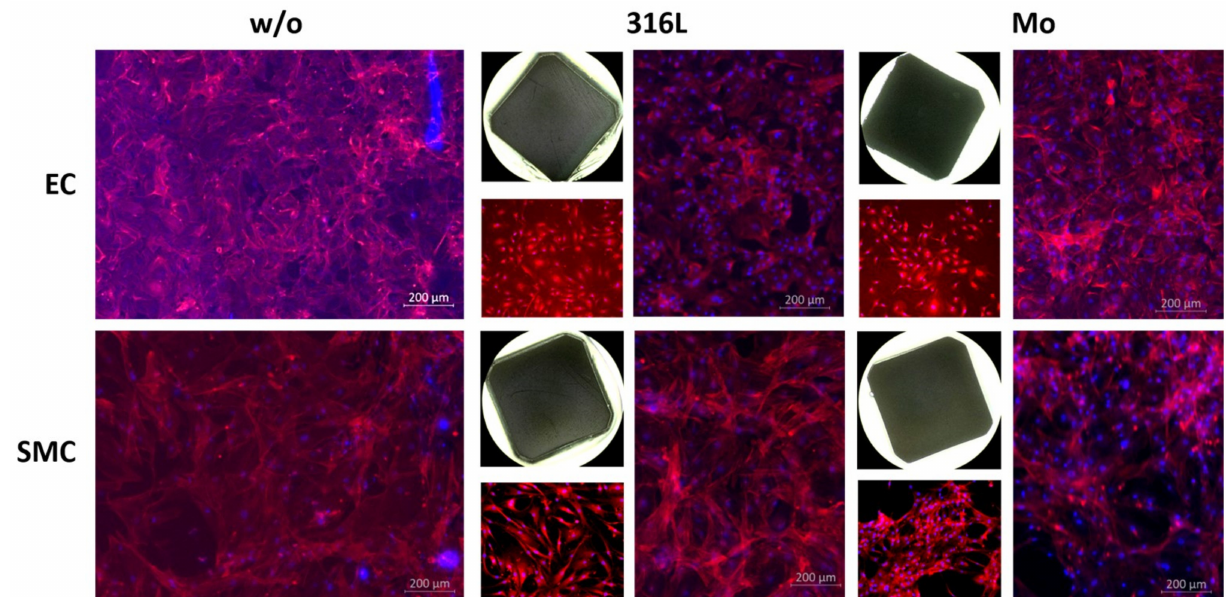
Figure 8. Colonialization of metal slices (Mo and 316L) by HCAECs or HCASMCs compared to culture dishes without metallic samples (w/o). In case of either metal, fluorescence microscopy reveals attached cells after 6 h of